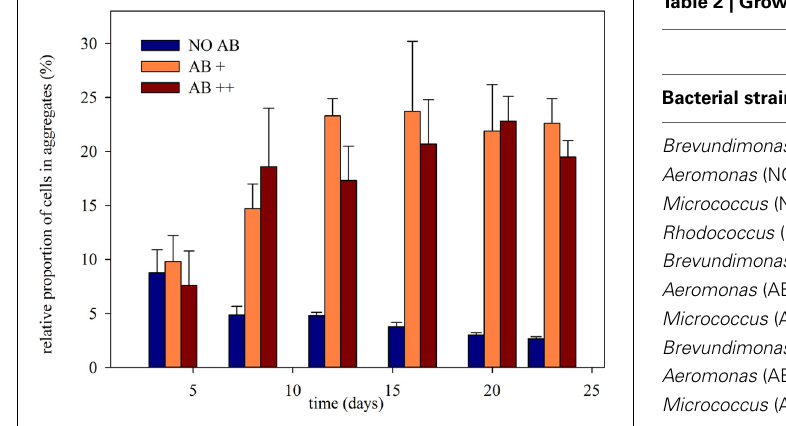
FIGURE 4 | Relative proportion of cells clustered in continuous culture vs. time. The relative proportion of aggregated cells is given as mean of three replicates ( ± SD ) for each of the three treatments.